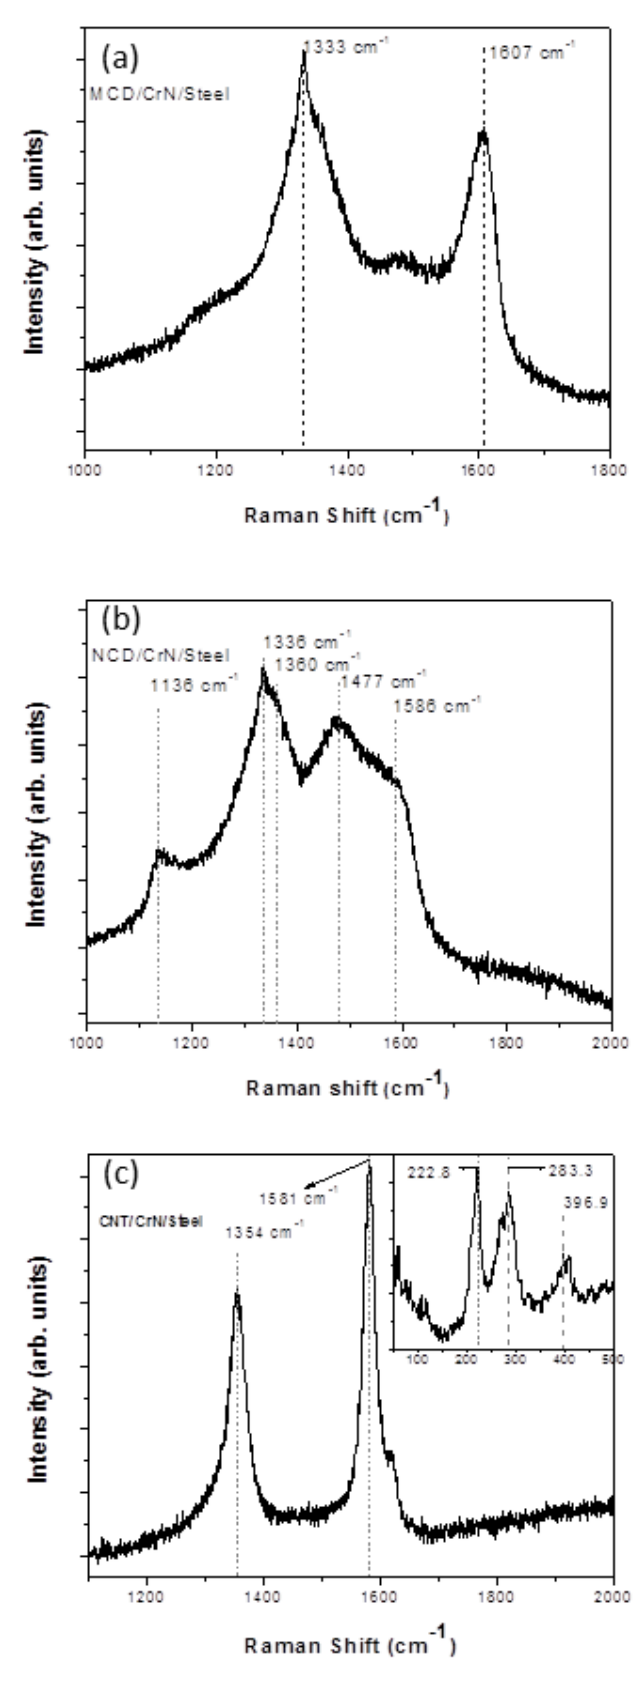
Figure 1. Raman spectra of materials grown on CrN-coated stainless steel substrates: ( a ) MCD/CrN/Steel; ( b ) NCD/CrN/Steel; and ( c )